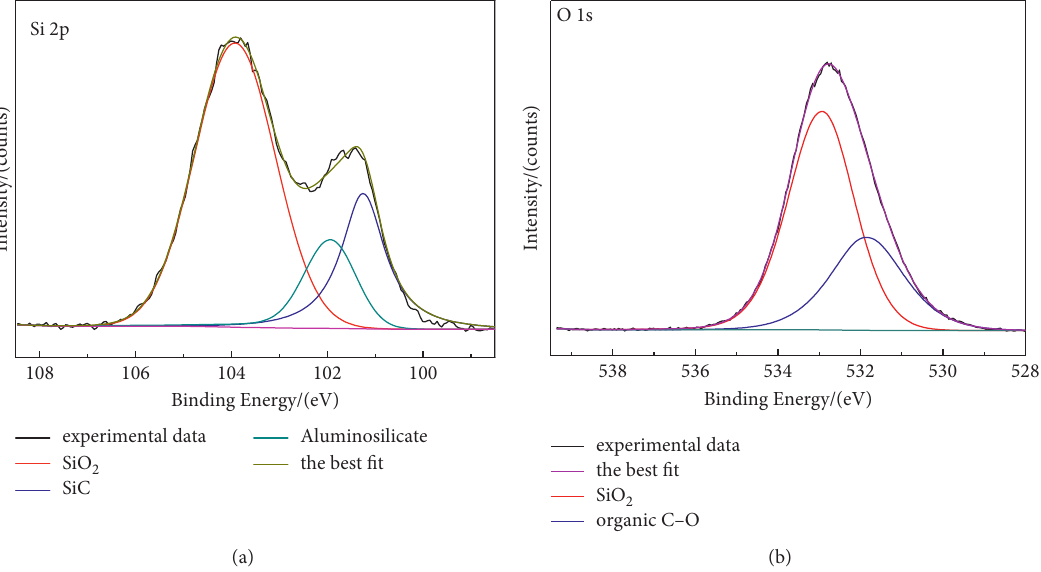
Figure 6: The spectra deconvolution of Si 2p and O 1s at 1,200 ° C.